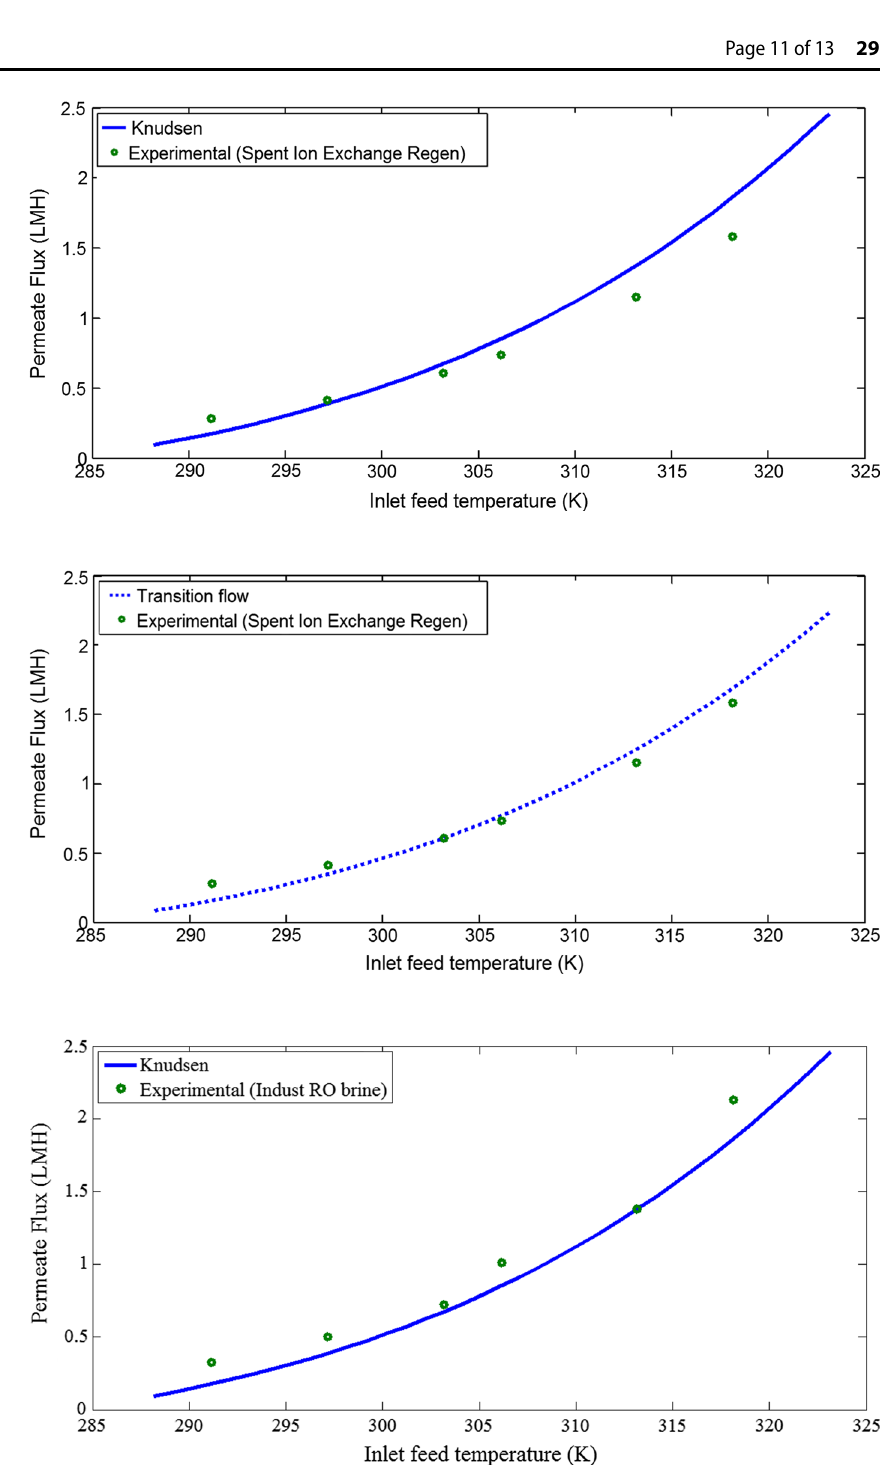
Fig. 9 A comparison between the Knudsen model and experi- mental results for spent ion exchange regenerant